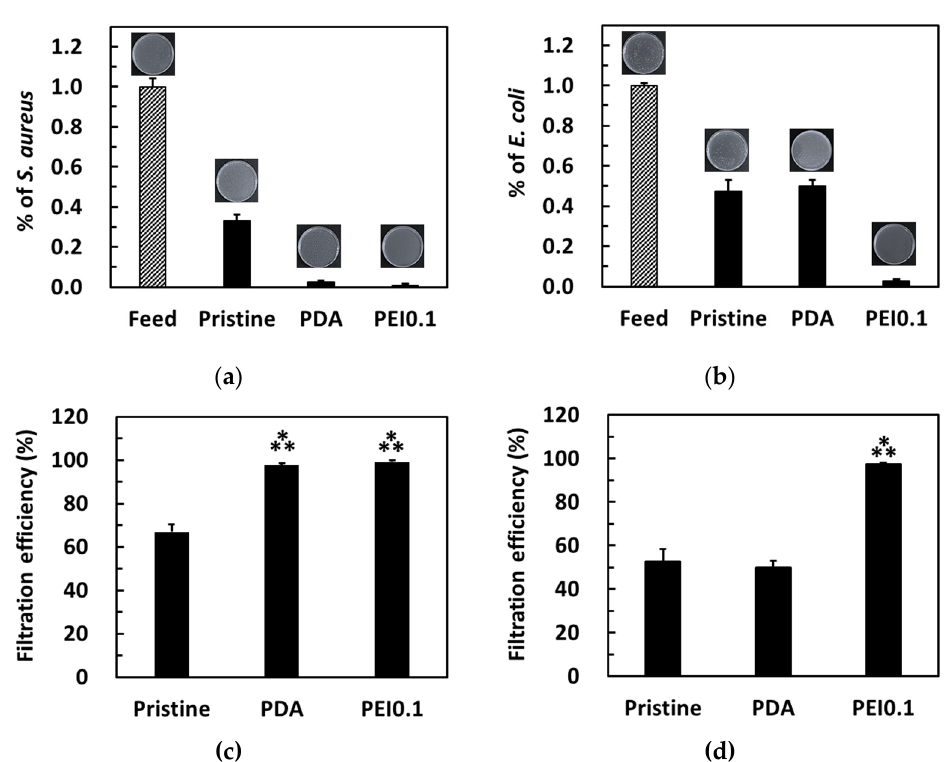
Figure 8. Colonies formed on the agar plate by S. aureus ( a , c ) and E. coli ( b , d ) in water before and after filtration through the different filter papers. Filtration efficiency for different filter papers. ***, p < 0.001 vs. pristine.